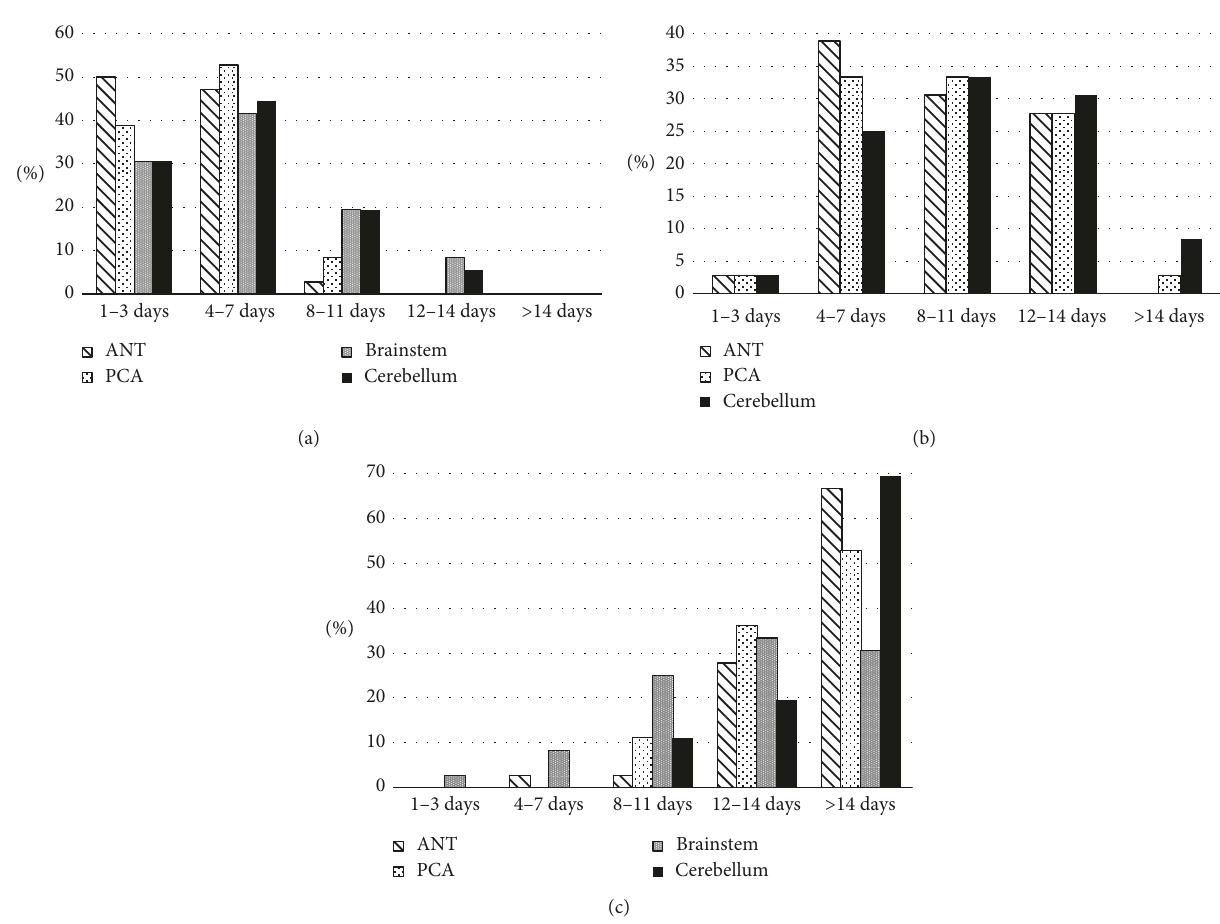
Figure 1: Participants’ responses to the questions of when they would initiate NOACs after nvAF-related stroke, sorted according to stroke location and size. ANT, anterior circulation; PCA, posterior cerebral artery: (a) small stroke, (b) medium stroke, and (c) large